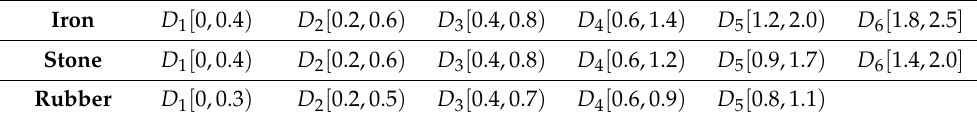
Table 10. Interval settings of domains for different materials.